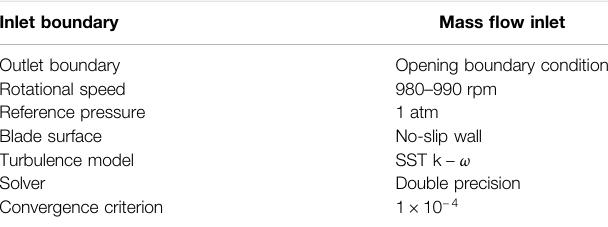
TABLE 2 | Boundary conditions and convergence criteria for